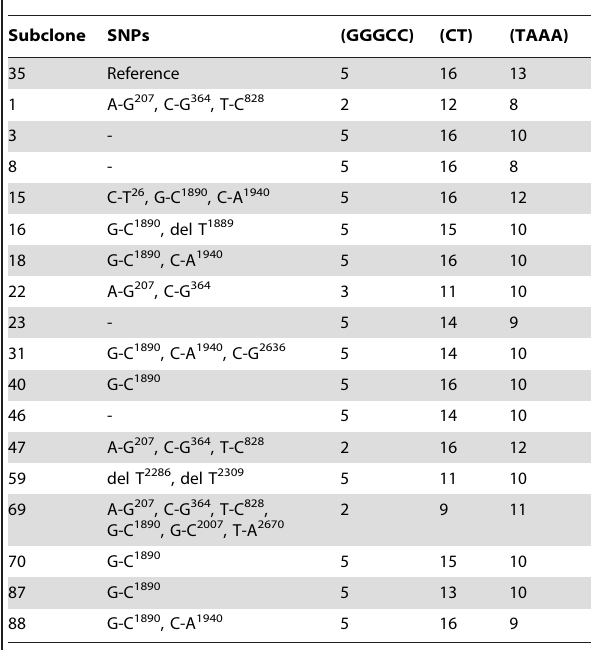
Table showing sequence variation for the 18 DXZ4 monomer subclones isolated from BAC clone 2272M5. SNP coordinates are based on the reference sequence of subclone 35. Absent bases are given the prefix ‘‘del’’. Copy number of the pentameric (GGGCC), tetrameric (TAAA) and dimeric (CT) microsatellites are indicated. Accession numbers for monomers listed above are as follows: DXZ4-1 - HQ659103; DXZ4-3 - HQ659104; DXZ4-8 - HQ659105; DXZ4-15 -